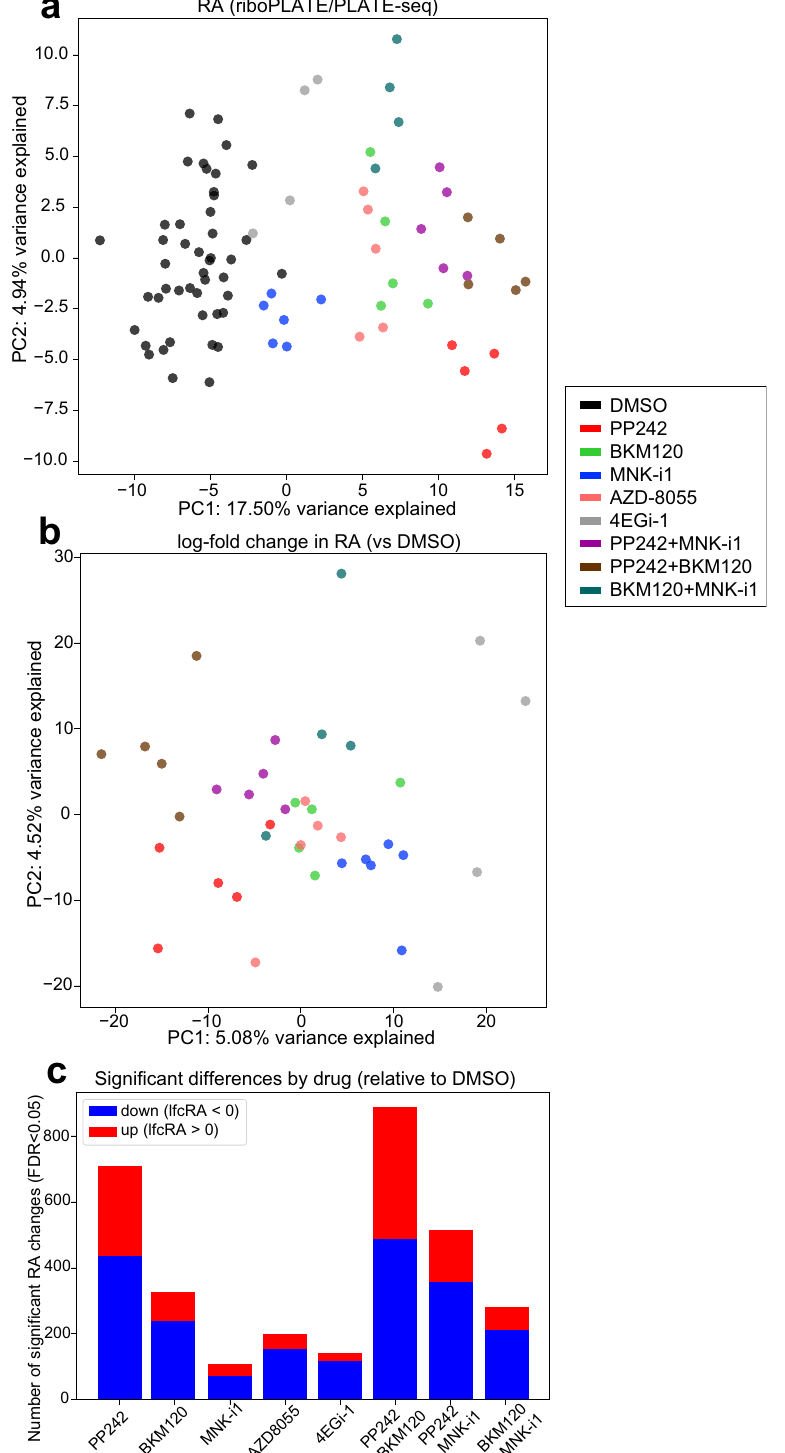
Figure 4. Principal Component Analyses (PCA) of riboPLATE-seq data in TS-543 cells. ( a ) riboPLATE-seq ribosome association (RA, riboPLATE-seq-PLATE-seq), ( b ) difference in RA between each sample and the average across DMSO-treated samples (lfcRA), normalized by variance-stabilizing transform (VST) in DESeq2 (R v4.0.5). For both plots, the domain of the PCA was restricted to genes with significant changes in RA reported by DESeq2 for any drug treatment relative to DMSO, (FDR < 0.05, 1813 genes